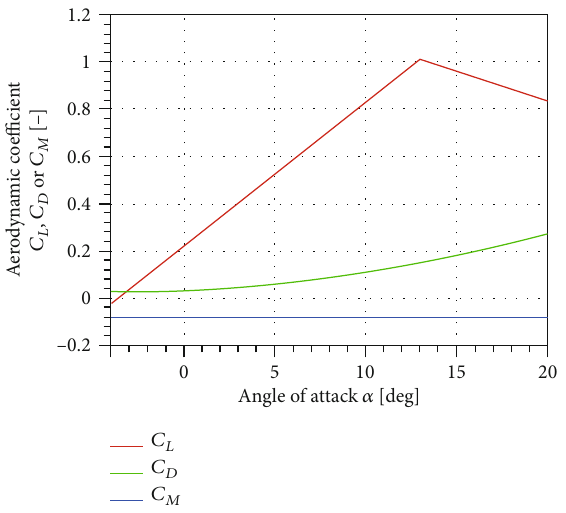
Figure 5: Pitching moment characteristics of the parafoil for various RA.